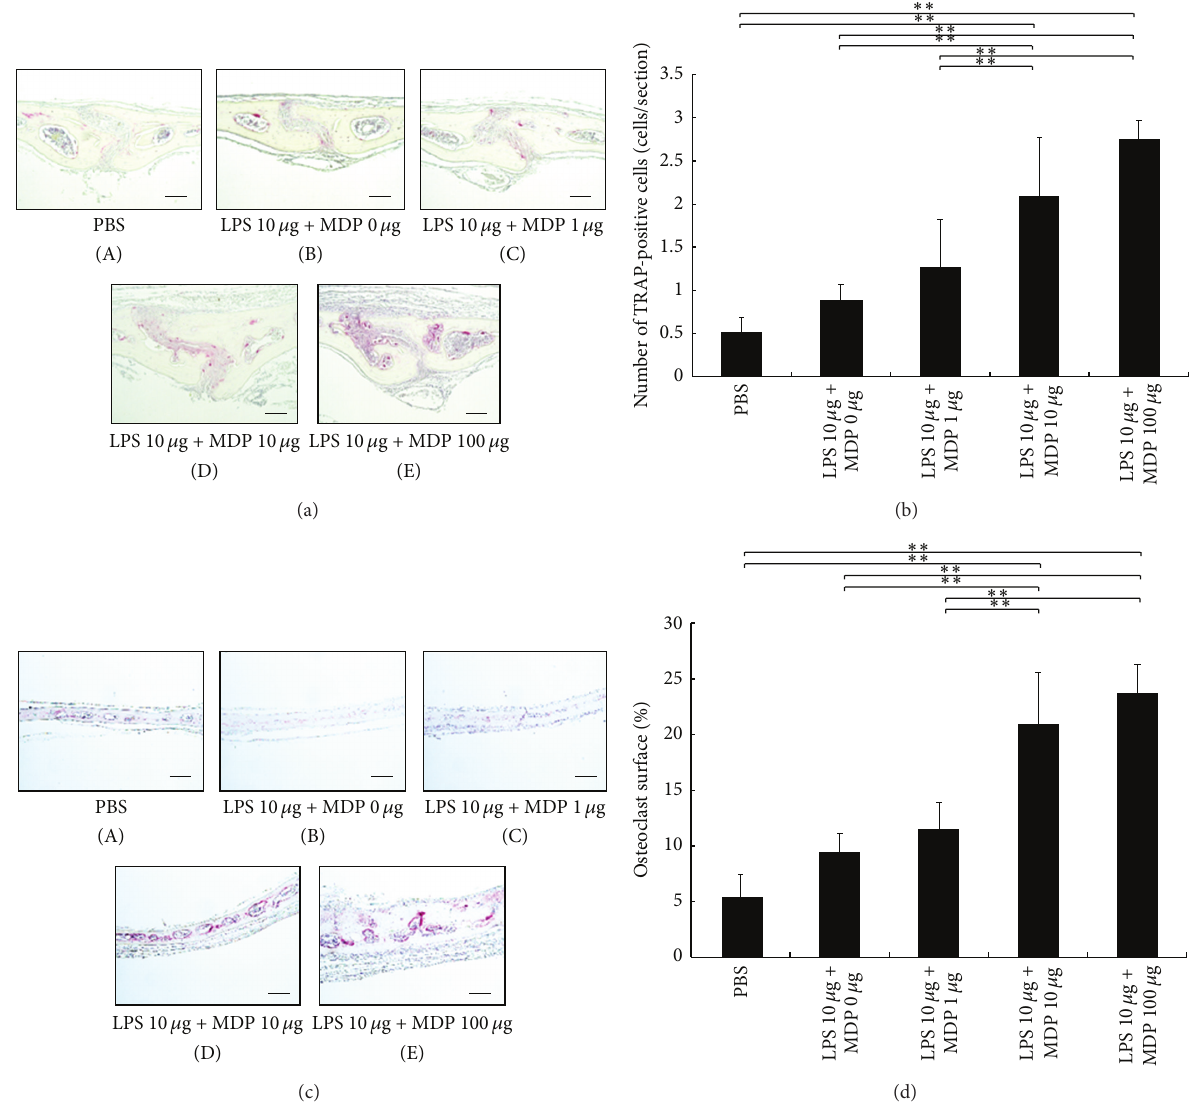
Figure 2: Osteoclast formation is dependent on muramyl dipeptide (MDP) concentration. (a) Osteoclast number in the sutures following treatment with a low concentration of lipopolysaccharide (LPS) (10 𝜇 g/day) with increasing concentrations of MDP for 5 days. Sections were stained with tartrate-resistant acid phosphatase (TRAP) staining and counterstained with hematoxylin. Cells that stained red are considered to be TRAP-positive. Scale bars = 50 𝜇 m. (b) Number of TRAP-positive cells with three or more nuclei in the calvariae ( 𝑛 = 4 ; ∗∗ 𝑃 < 0.01 ). (c) Osteoclast number in the bone/marrow interface following treatment with a low concentration of lipopolysaccharide (LPS) (10 𝜇 g/day) with increasing concentrations of MDP for 5 days. Sections were stained with tartrate-resistant acid phosphatase (TRAP) staining and counterstained with hematoxylin. Cells that stained red are considered to be TRAP-positive. Scale bars = 100 𝜇 m. (d) The percentage of bone/marrow interface covered by osteoclasts was histomorphometrically determined in specimens ( 𝑛 = 4 ; ∗∗ 𝑃 < 0.01 ). Differences were detected using Scheffe’s 𝐹